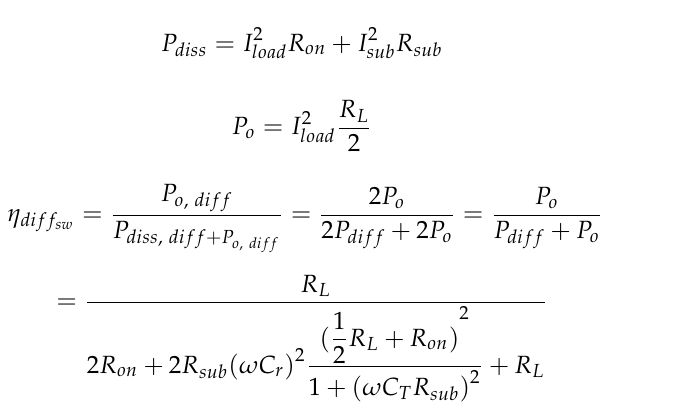
Figure 6. Efficiencies of impedance matching networks. Solid symbols and vacant symbols represent efficiencies of multi-section and single-section matching, respectively.